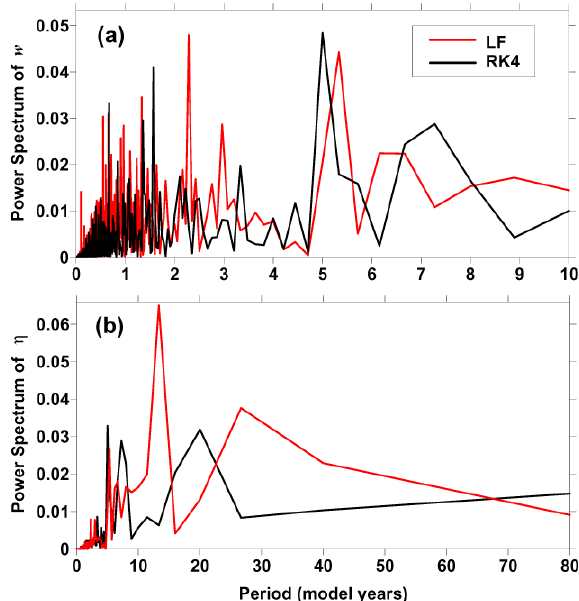
Fig. 3. Power spectra of (a) w and (b) η based on the model data between 10 3 and 10 4 TUs derived from both the LF (red line) and the RK4 (black line) time-differencing